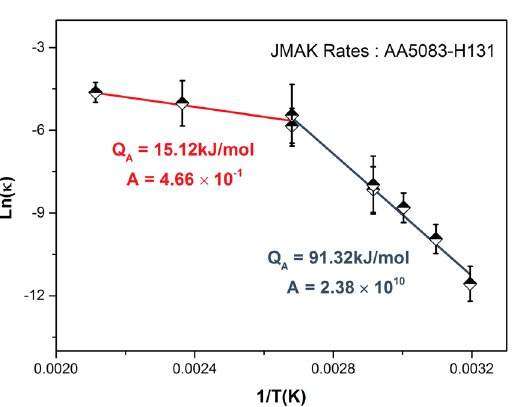
Figure 10. ( a ) The lines represent DoS values predicted by the CALPHAD model which is yielded by Eqs (1) and (8), and the experimental DoS values are presented in the form of scatter data points. ( b ) Degree of sensitisation (NAMLT values) as a function of isothermal aging time for AA5083. The dotted line for JMAK 40 °C ~ 100 °C represents estimated DoS of sensitised AA5083-H116 from a the JMAK model presented in ref. 29, whilst the JMAK 150 °C and 200 °C lines are calculated according to the values in Fig. 11.